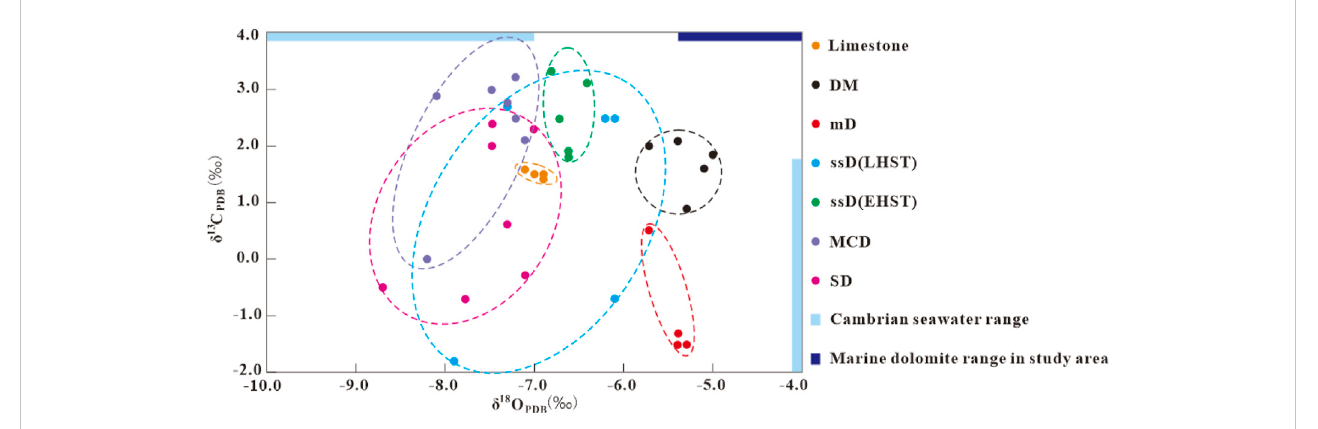
FIGURE 8 Carbon and oxygen isotopic crossplot of the upper changping